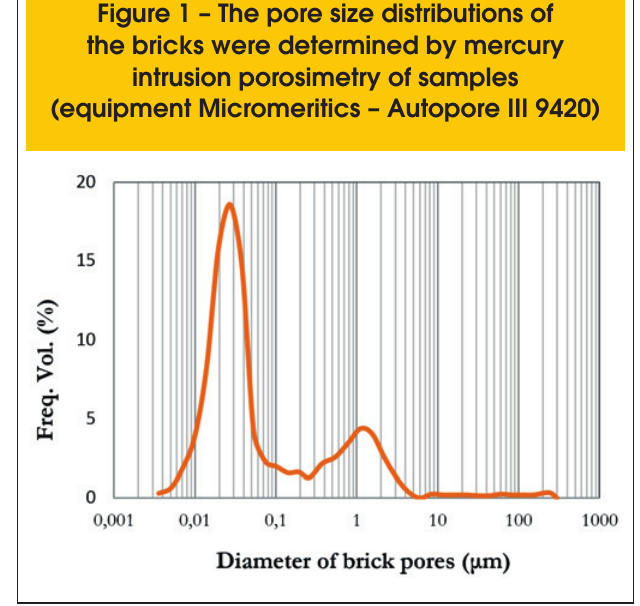
Figure 1 – The pore size distributions of the bricks were determined by mercury intrusion porosimetry of samples (equipment Micromeritics – Autopore III